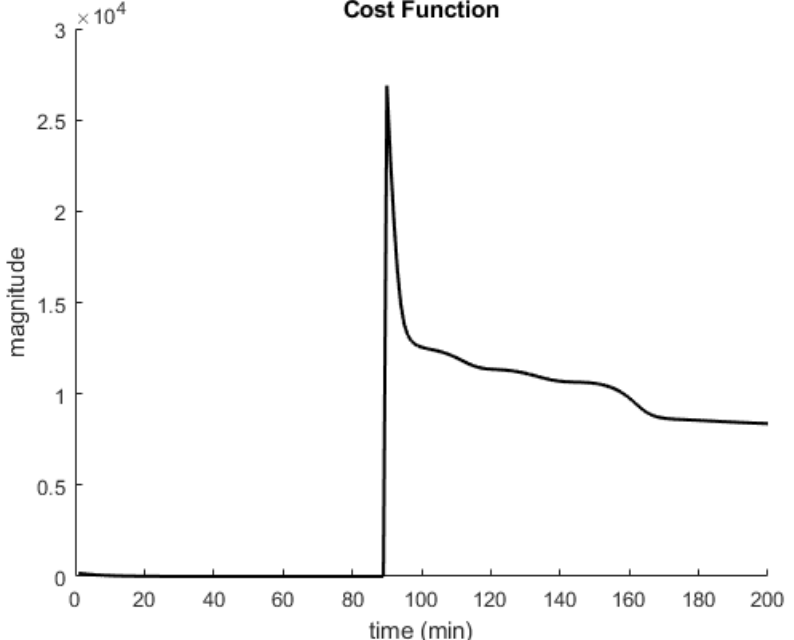
Figure 11. Control cost function for the gas lift system. The first part corresponds to u des = 0.65, which is in the stable region. The second part corresponds to u des = 1.25, which is out of the input bound. The cost function decreases to zero for the first part that the input is reachable but leaves an offset for the unreachable